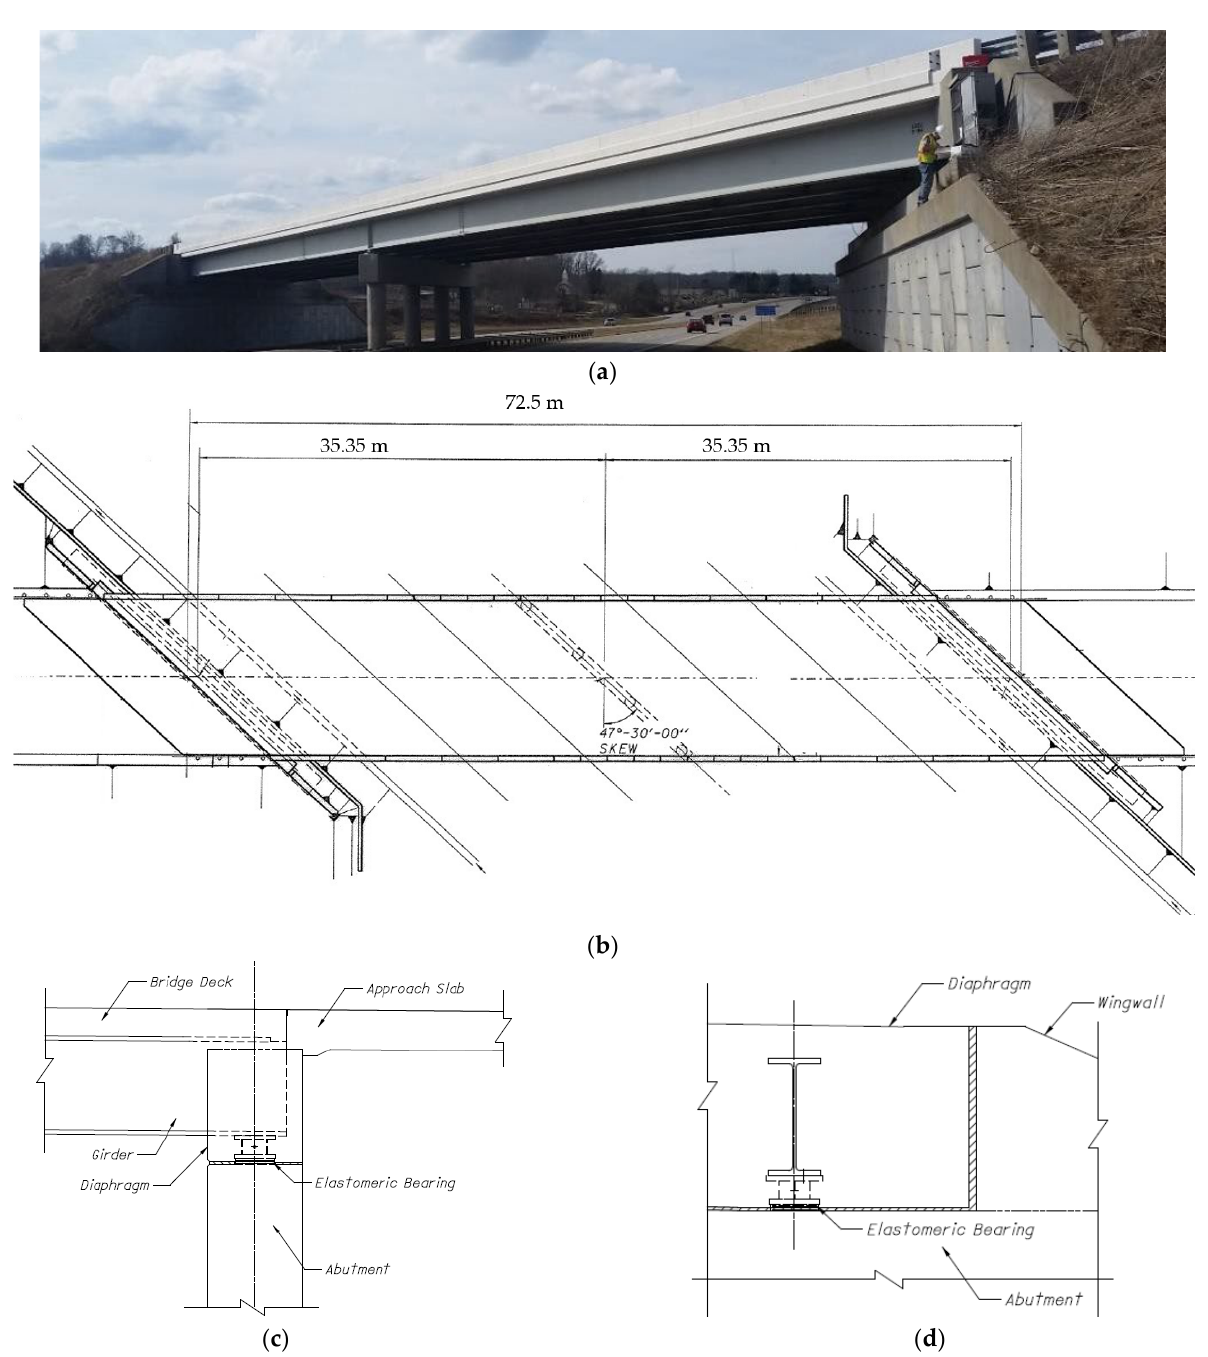
Figure 1. Bridge details ( a ) bridge overview, ( b ) plan view, ( c ) abutment cross section, and ( d ) ele- vation view.